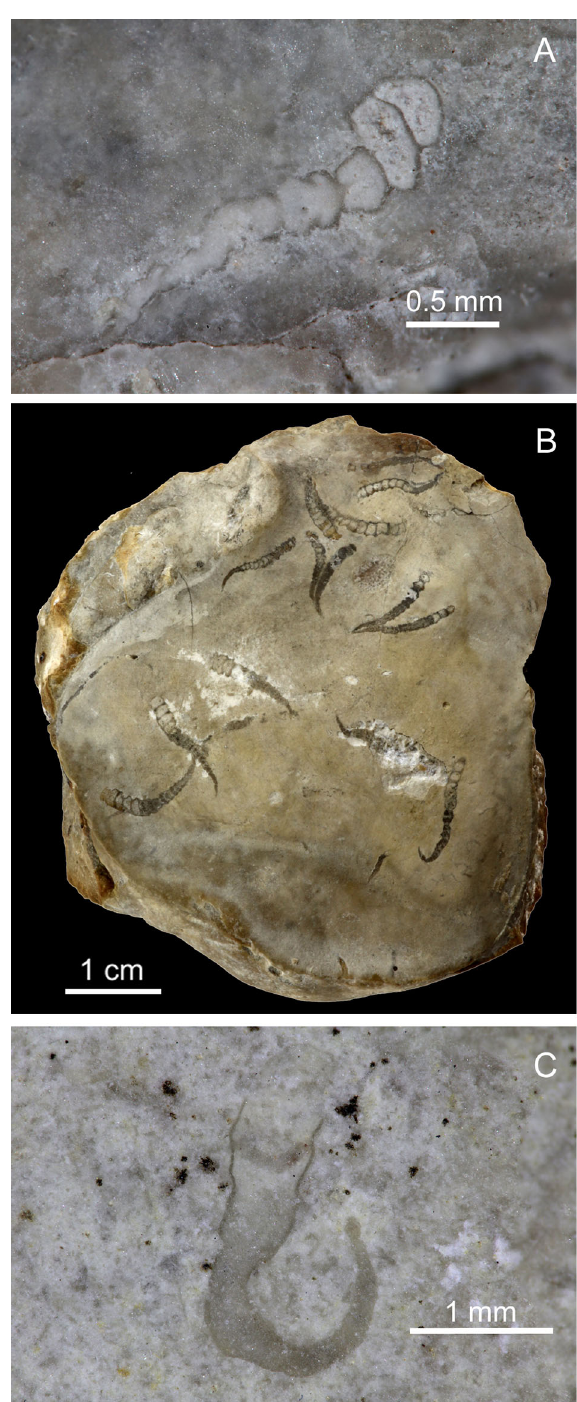
Fig. 2. A , Cornulites sp. on the internal mould of the Illaenus sp. pygidium from Aru, northern Estonia, Lasnamägi Regional Stage (Darriwilian) (TUG 35-55); B , Cornulites sp. tubes on the internal mould of the illaenid pygidium from Pühalepa, Hiiumaa Island, Nabala Regional Stage (Katian) (TUG 2-650); C , Conchicolites ? sp. on the internal mould of the illaenid pygidium from Moe ditch, northern Estonia, Vormsi Regional Stage (Katian) (GIT